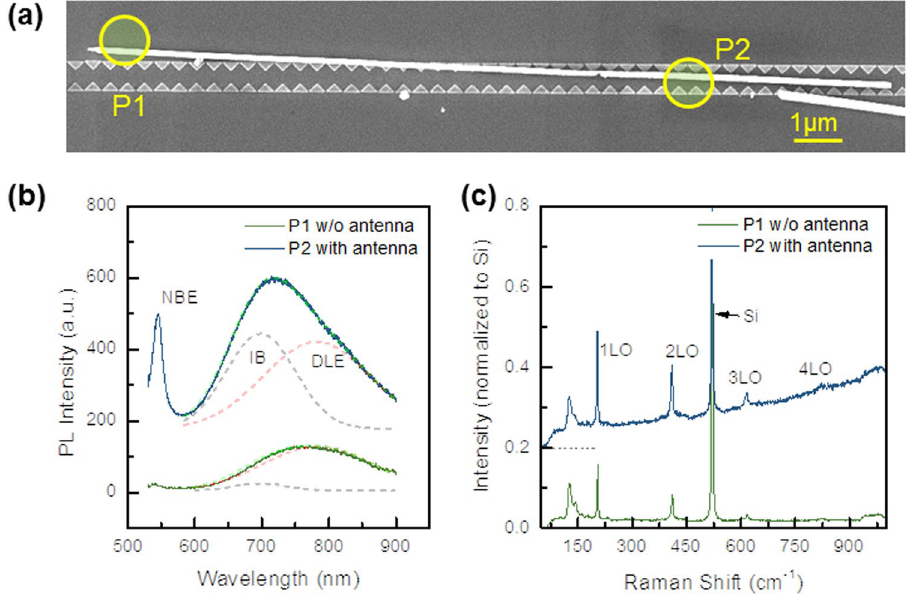
Figure 5. ( a ) SEM image of a 140-nm-radius ZnTe:O/ZnO core shell nanowire integrated with one- dimensional Al antenna array; ( b ) Micro-photoluminescence and ( c ) resonant Raman scattering from nanowire parts located within or outside of the coupled Al bowtie antenna